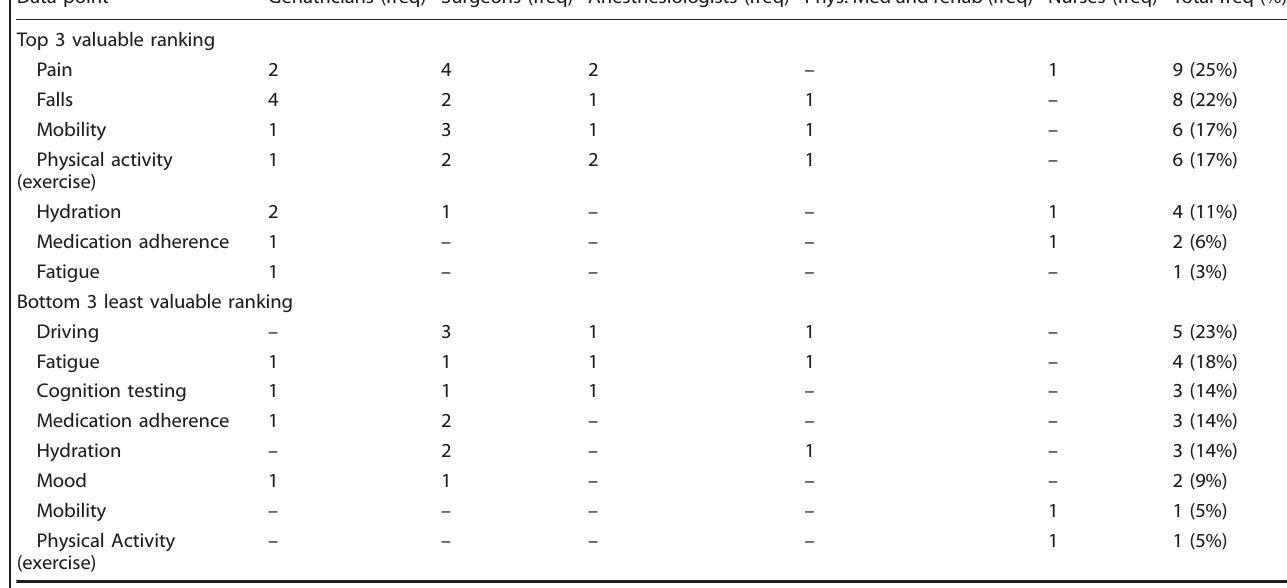
Table 2. Data rankings a . Data